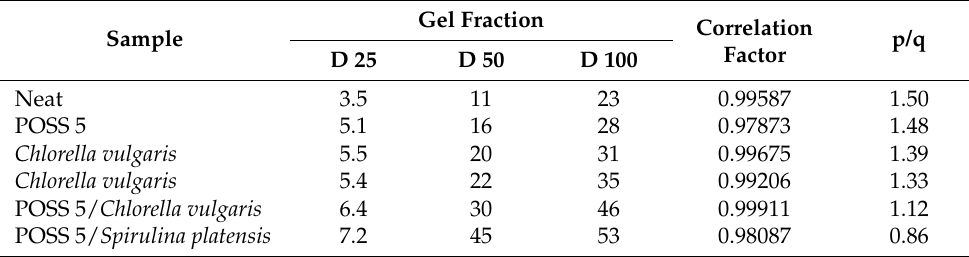
Table 2. Gel fractions in irradiated EPDM-based